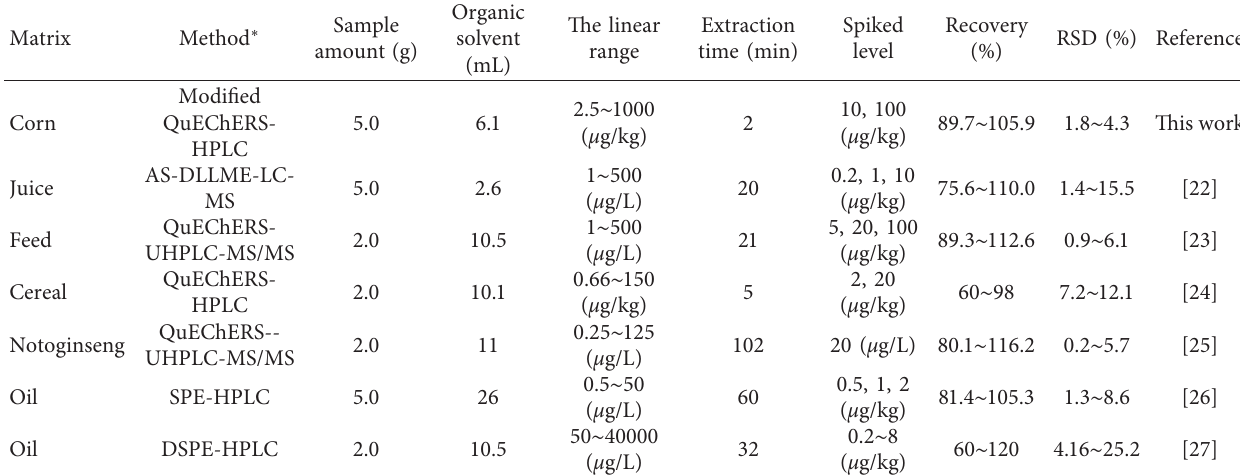
Table 3: Comparison of the proposed method with other